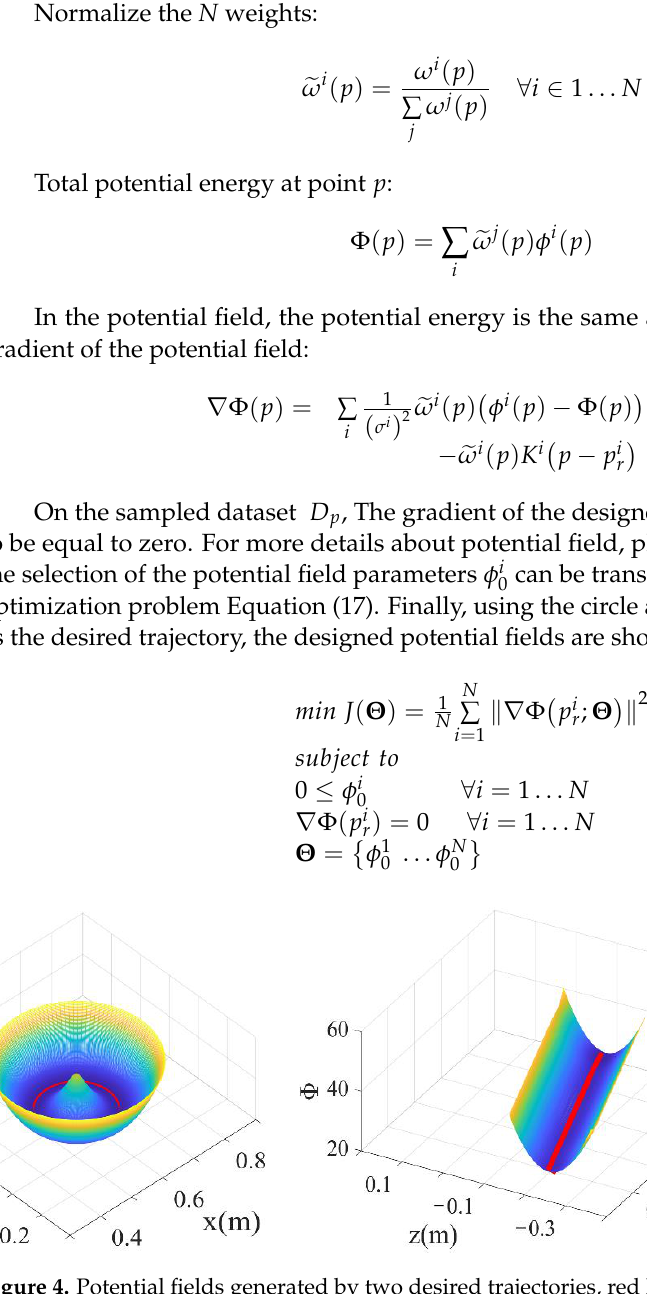
Figure 4. Potential fields generated by two desired trajectories, red line indicates desired trajectory.